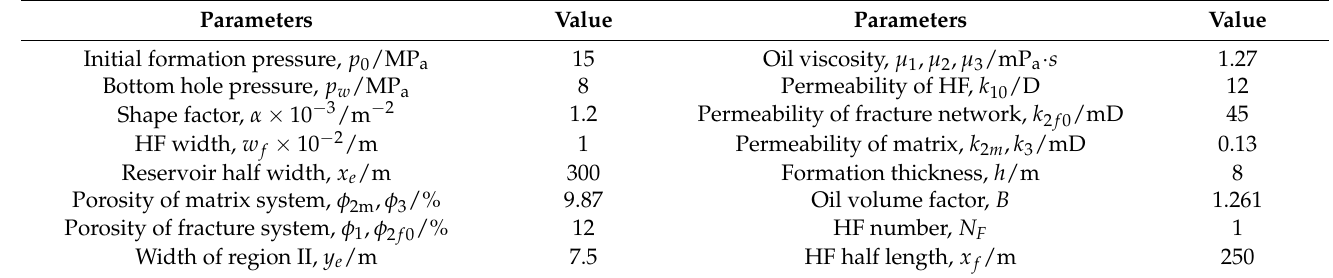
Table 1. Simulation